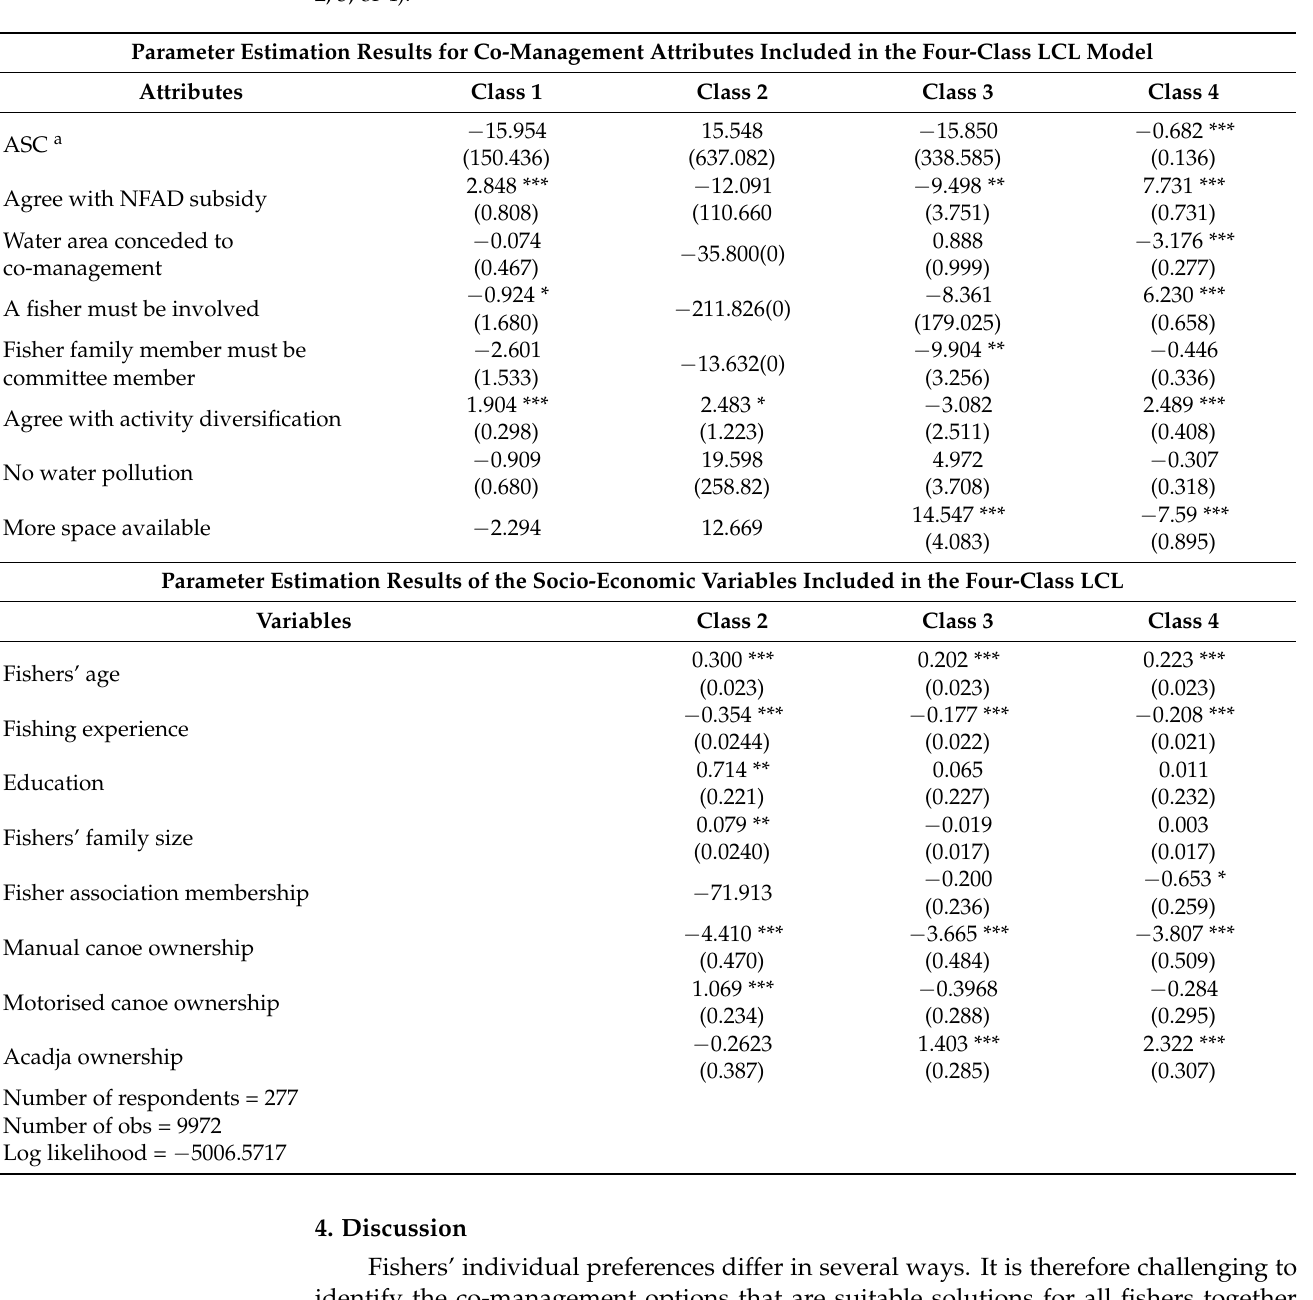
Table 7. Latent class model results ( a = ASC (status quo) is current management practices (1 if the respondent chooses the status quo and 0 otherwise). Numbers without brackets are estimated parameters; numbers in brackets are standard errors of the estimated parameters. *, **, *** indicate statistical significance at 1, 5, and 10 percent levels, respectively. Class 1 was considered as the reference. This means that a positive parameter indicates a higher probability that the respondent with a given characteristic is a member of class 2, 3, or 4 compared to class 1. Conversely, a negative parameter indicates a higher probability that the respondent is a member of class 1 compared to class 2, 3, or